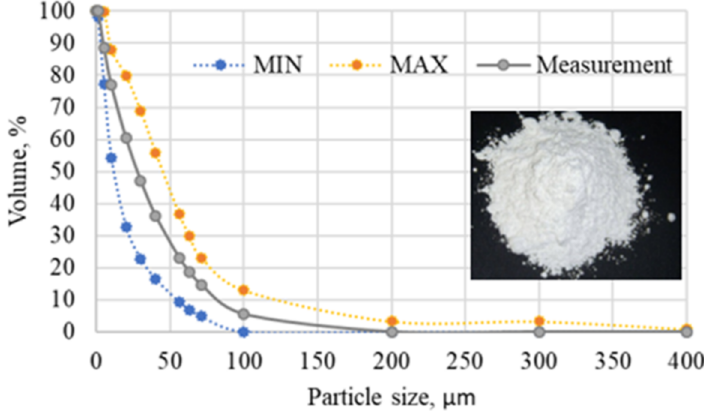
Figure 4. Distribution of particle volume fraction as a function of quartz flour grain